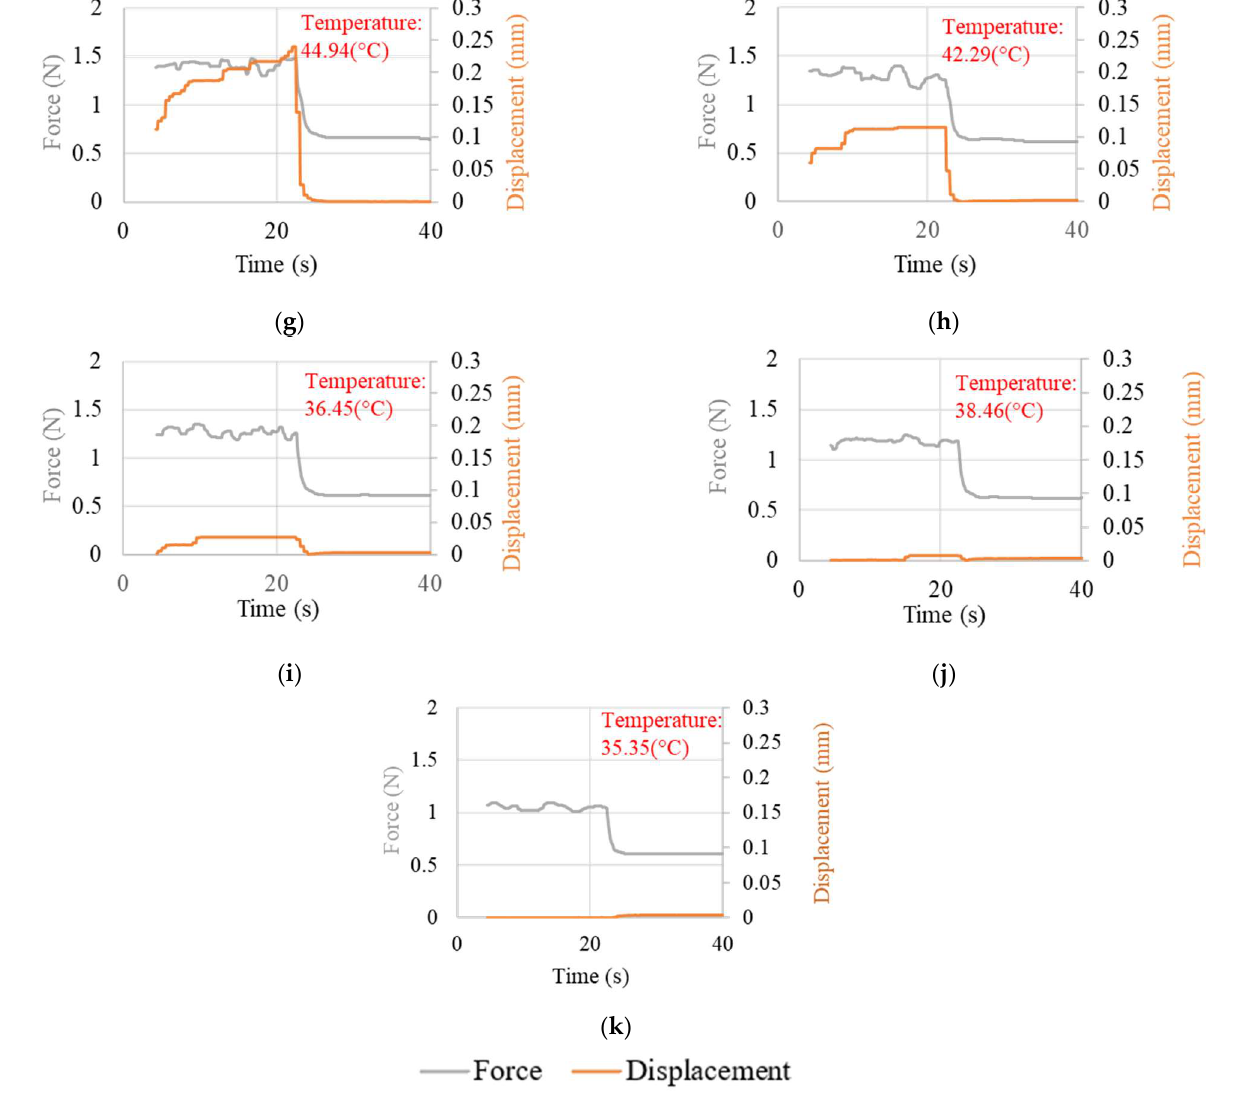
Figure A3. Waveforms of the measurements at different heating currents with the average temper- ature of the heated sample: ( a ) 200 mA; ( b ) 190 mA; ( c ) 180 mA; ( d ) 170 mA; ( e ) 160 mA; ( f ) 150 mA; ( g ) 140 mA; ( h ) 130 mA; ( i ) 120 mA; ( j ) 110 mA: ( k ) 100 mA. Sample diameter, 100 µ m.